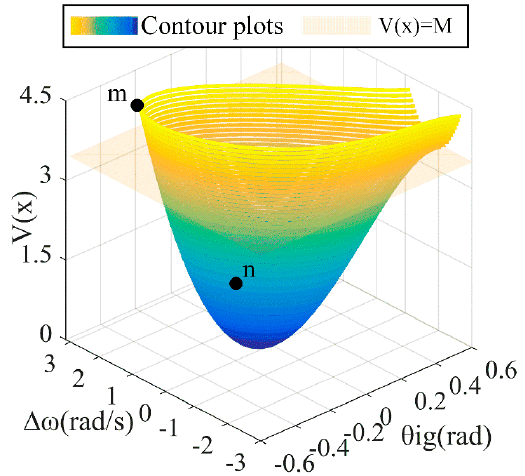
Figure 7. Contour plots of V function.